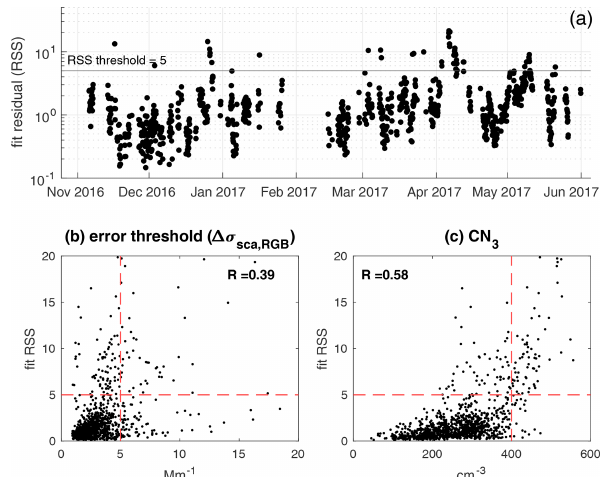
Figure 8. (a) Times series of the fit residual (residual sum of squares, RSS) between the retrieved sea spray mode and the UH- SAS mass size distribution within the 0.38–0.83µm fitting region. The horizontal line in (a) delineates the RSS restriction threshold of 5 used in this procedure. Note the logarithmic y axis. (b, c) Selected variables used to restrict sea spray mode retrievals defined by the fit residual (fit RSS, y axes): (b) error threshold ( (cid:49)σ sca , RGB , Mm − 1 ) and (c) condensation nuclei concentration of particles > 3nm opti- cal diameter (CN 3 , cm − 3 ) . Retrieval restriction thresholds are sym- bolized by dashed red lines in (b, c) . Pearson correlation coefficients ( p < 0 . 05) are provided within panels (b, c)